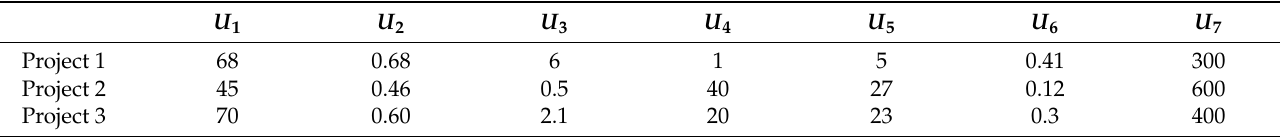
Table 4. Data required by the model.